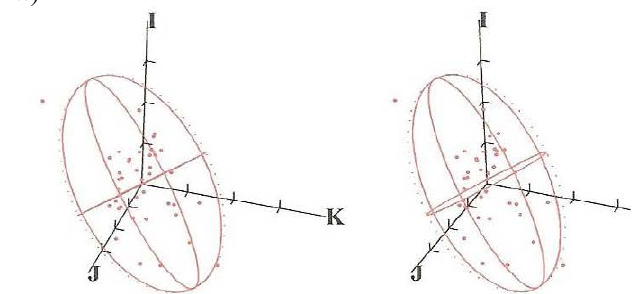
Figure 2: Stereo-pair scatter plot of symmetric dioptric power space for the anterior ( a ) and posterior ( b ) corneal keratometry for Subject 2. The origin for each stereo-pair is the respective sample mean.